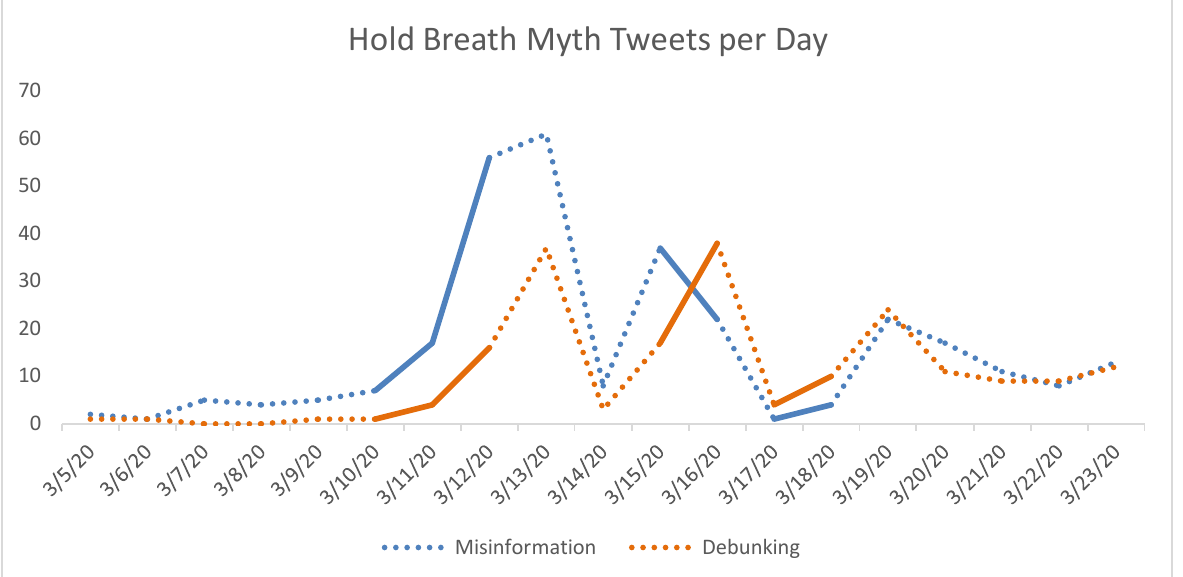
Figure 4. Hold breath misinformation tweets vs. hold breath debunking tweets over time. The solid line indicates the days when the difference in proportion between misinformation and debunking tweets was significant (p < .05) according to a Chi- square Test for Independence. The dotted line indicates the days when the proportion of the two types of tweets did not differ significantly.